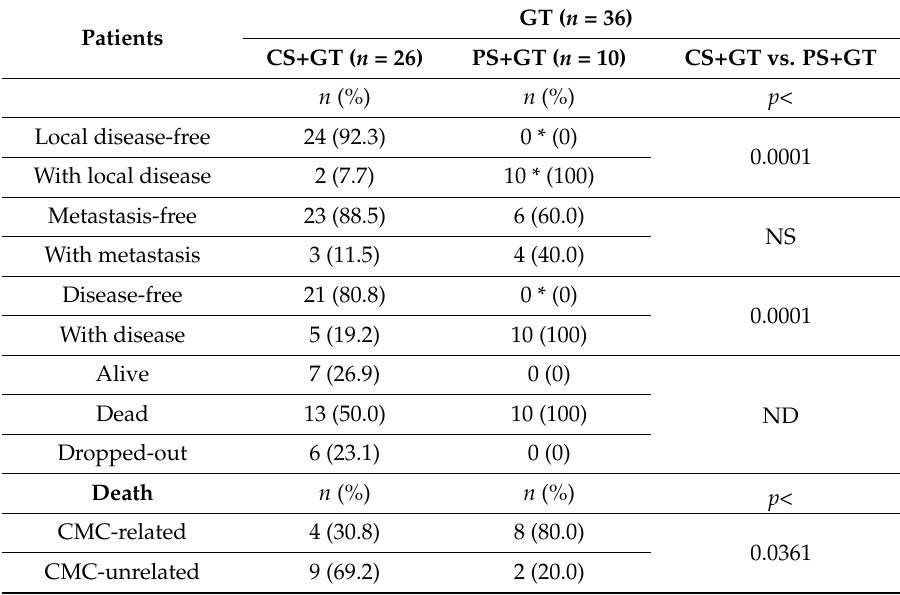
Table 4. Disease status at the end of the study and causes of